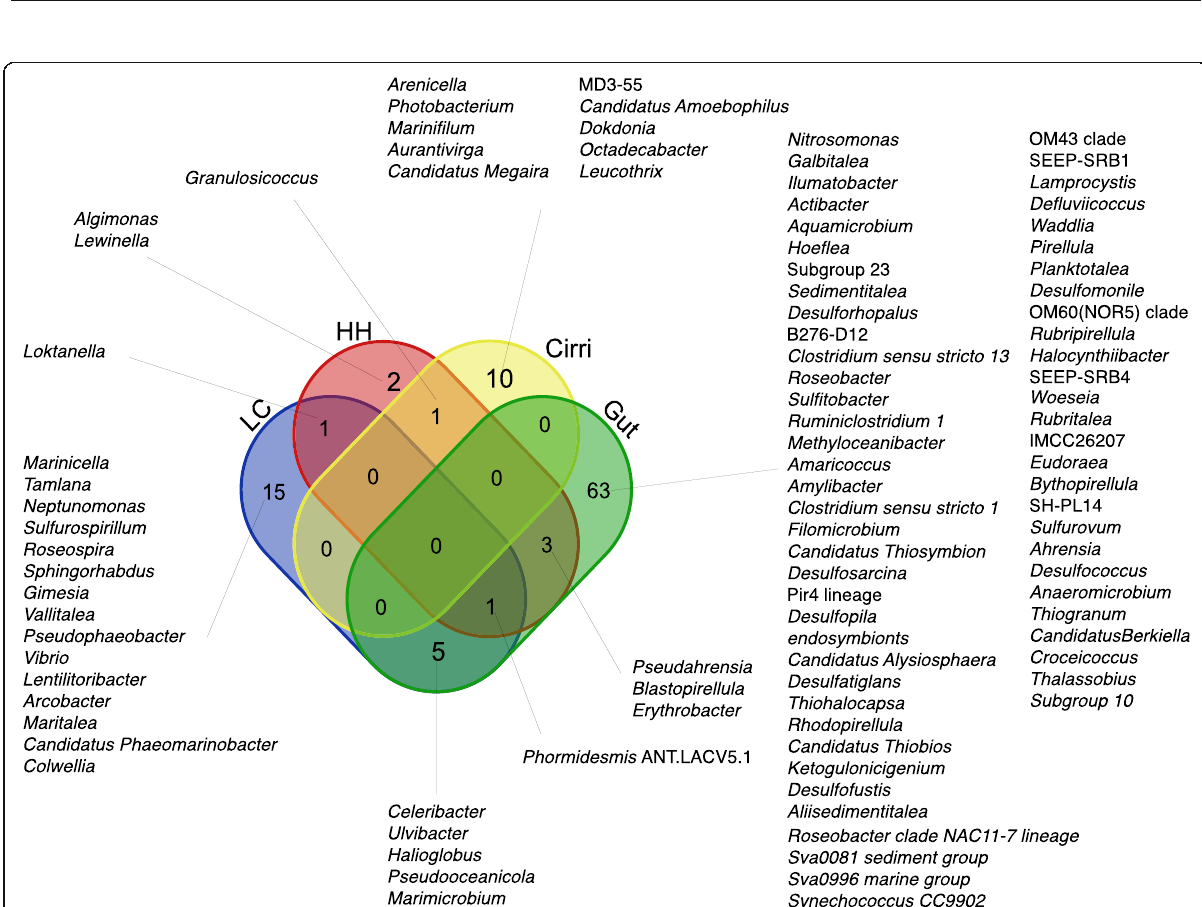
Fig. 3 Microbiome diversity of cirri and gut within the intertidal and across locations of 21 samples (10 cirri;11 gut). a Shannon diversity index of cirri and gut samples. b PCoA of Bray – Curtis dissimilarity distances among samples. Numbers represent individuals. Gut and cirri samples with the same number are from the same host